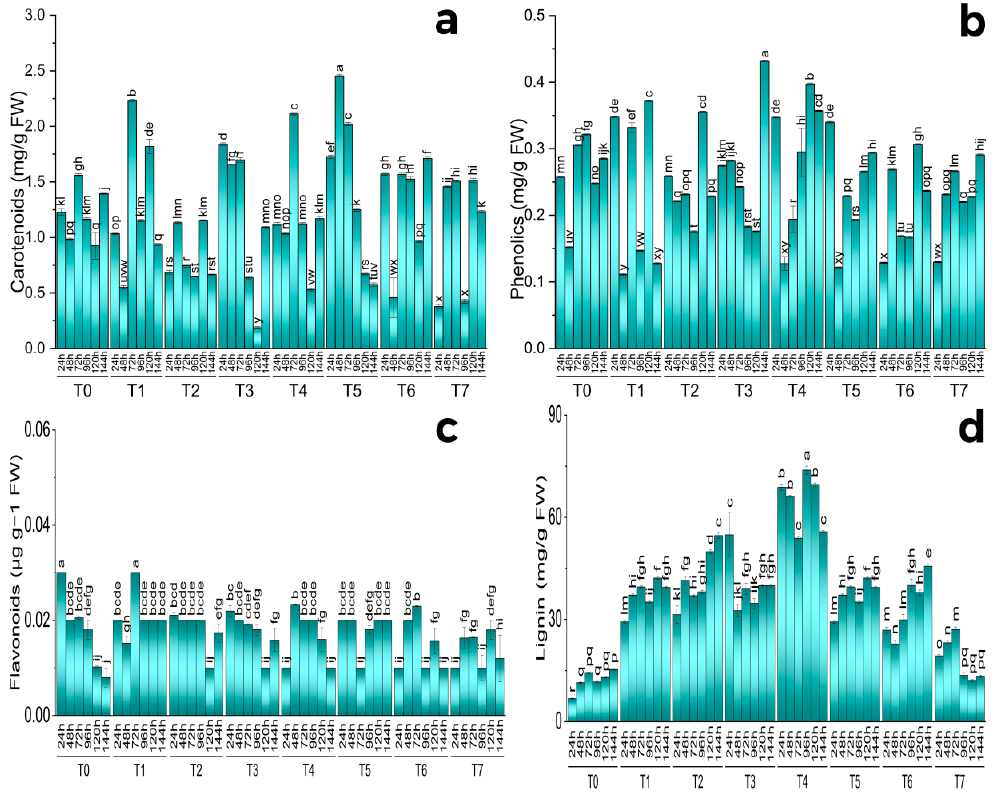
Figure 3. Effect of different treatments of elicitors on Carotenoids ( a ), Phenolics ( b ), Flavonoids ( c ), and Lignin ( d ) contents of Silybum marianum in hydroponics where harvest time on x-axis, first = one day (24 h), second = 48 h, third = 72 h, fourth = 96 h, fifth = 120 h, sixth = 144 h, where (T0 = control, T1 = methyl jasmonate, T2 = silver nanoparticles, T3 = fungal elicitors, T4 = methyl jasmonate + fungal elicitors, T5 = methyl jasmonate + silver nanoparticles, T6 = fungal elicitors + silver nanoparticles, T7 = methyl jasmonate + silver nanoparticles + fungal elicitors); different letters on the bars indicate a difference that was significant at p > 0.05; Tukey test.